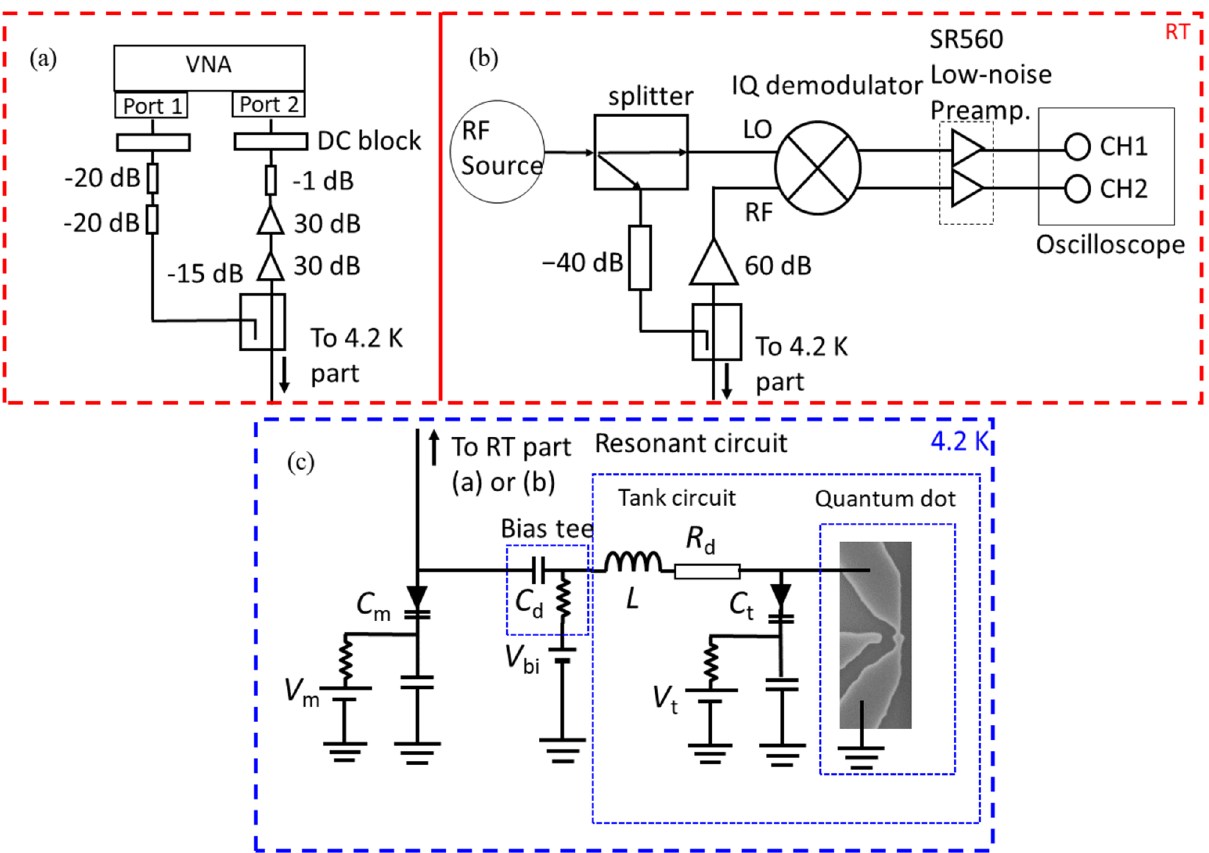
Figure 5. Measurement setup. ( a ) Room temperature part of the circuit used for the resonant frequency f r dependence measurement. The rf signal at 0 dBm is first attenuated before entering a directional coupler and being sent to the quantum dot via the resonant circuit at low temperature. The reflected signal is then amplified at high gain before being measured at the port 2 of the vector network analyzer (VNA). ( b ) Room temperature part of the circuit used to readout the charge state. Here, the signal from the rf-source is split between the incident signal sent directly to the device at low temperature and the demodulator for the measurement of the in-phase (I) and quadrature (Q) components of the reflected signal. ( c ) The resonant circuit with an inductor of 277 nH together with the two varactors C m and C t . R d represents the losses in the measurement system including the dielectric losses in the device, the printed circuit board (PCB), and in tuning the